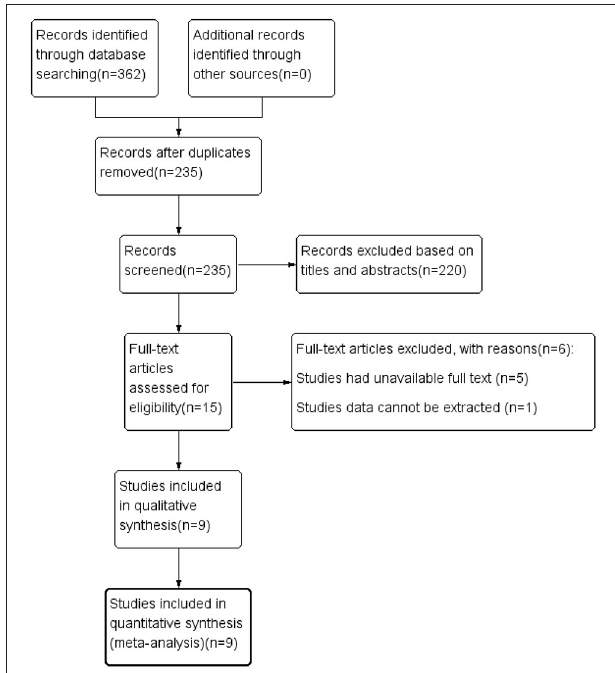
FIGURE 1 | Flow diagram by which eligible articles were selected.